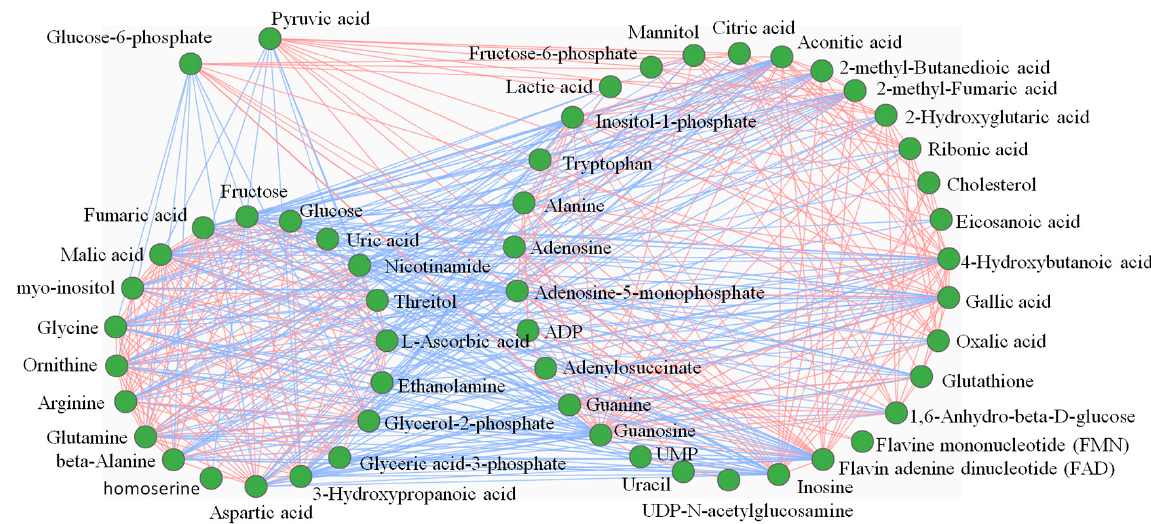
Figure 4. The correlation network diagram of differential metabolites. The Pearson correlation coefficient was used for metabolite correlation analysis using the calculation method cor () function in the R language package www.r-project.org (accessed on 22 December 2022). The Pearson correlation coefficient threshold was set to 0.8. The red lines represent positive correlations between substances, and blue lines represent negative correlations between substances.